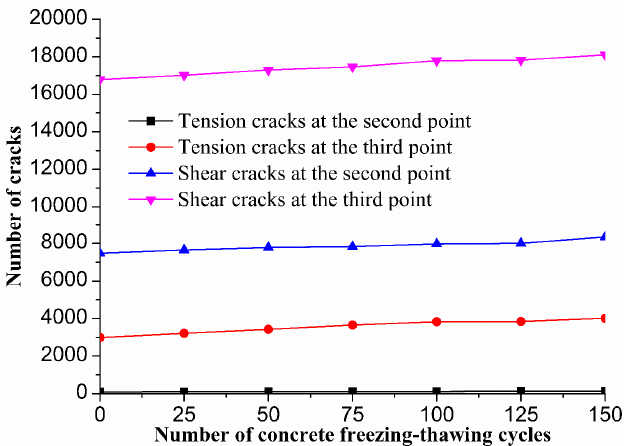
Figure 13. The number of cracks in two stage points of freezing–thawing-damaged concrete.